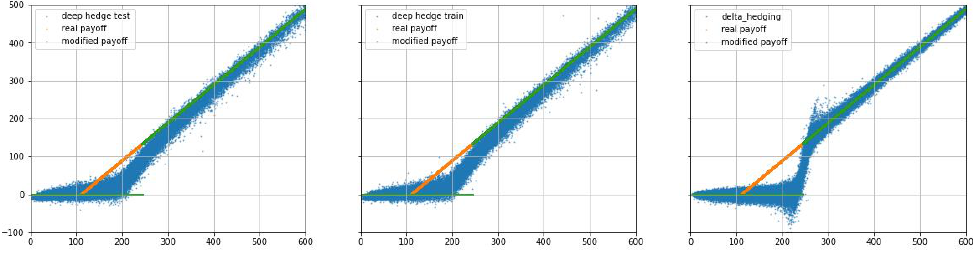
Figure 1. Terminal wealth ( p =